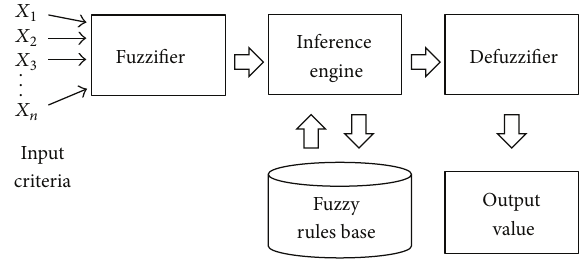
Figure 5: Diagram of the